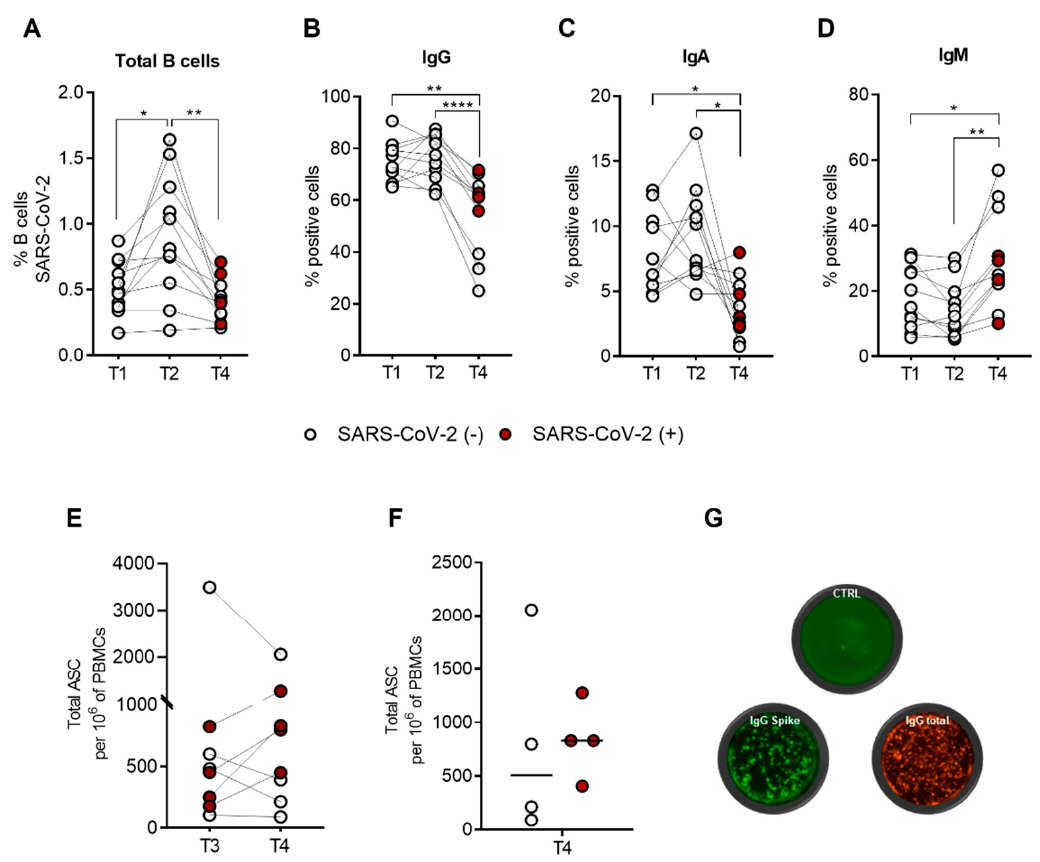
Figure 4. SARS-CoV-2-specific memory B-cell response in immunocompetent (IC), healthy subjects (n = 11) following Pfizer-BioNTech BNT162b2 mRNA-based vaccination. Spike-specific B cells were identified by flow cytometry nine months (T1) after the second dose and three weeks (T2) and six months (T4) after the third booster dose. Time point T4 includes vaccinated subjects who contracted SARS-CoV-2 infection during the follow-up (n = 5), indicated as SARS-CoV-2 (+) (red dots), and the uninfected (n = 6) are indicated as SARS-CoV-2 ( − ) (white dots). For recovered subjects, time point T4 corresponds to one month after a SARS-CoV-2-negative swab. ( A ) Percentage (%) of SARS-CoV-2-specific B cells at T1, T2, and T4. Comparison of percentage (%) of positive cell to surface immunoglobulin isotypes, IgG ( B ), IgA ( C ), and IgM ( D ) at T1, T2, and T4. ( E ) Total B-cells secreting IgG antibodies (ASC) specific to the SARS-CoV-2 spike protein at times T3 and T4. ( F ) Comparison between vaccinated SARS-CoV-2 (+) (n = 5) and SARS-CoV-2 ( − ) (n = 6) only at T4. ( G ) Representative examples of single-subject anti-IgG FluoroSpot assays. The control well represents unstimulated PBMCs, the IgG spike well is the stimulated PBMCs, and the IgG total well is the positive control. Significance was determined using Tukey’s multiple comparisons tests, one-way ANOVA, Wilcoxon matched-pairs test, Mann–Whitney test, and t -tests; * p < 0.0332: ** p < 0.0021; **** p <